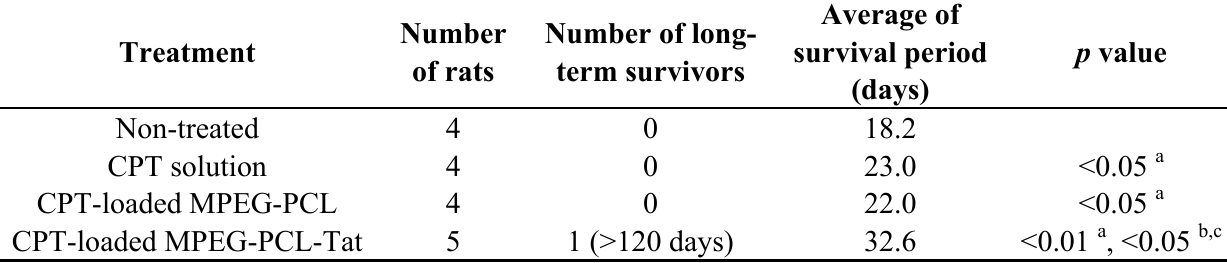
Table 3. Median survival period of rats bearing intracranial C6 glioma treated with camptothecin (CPT)-loaded